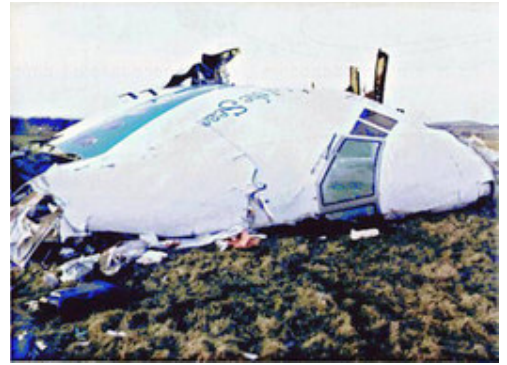
Fig 2. Nose section of Clipper Maid of the Seas